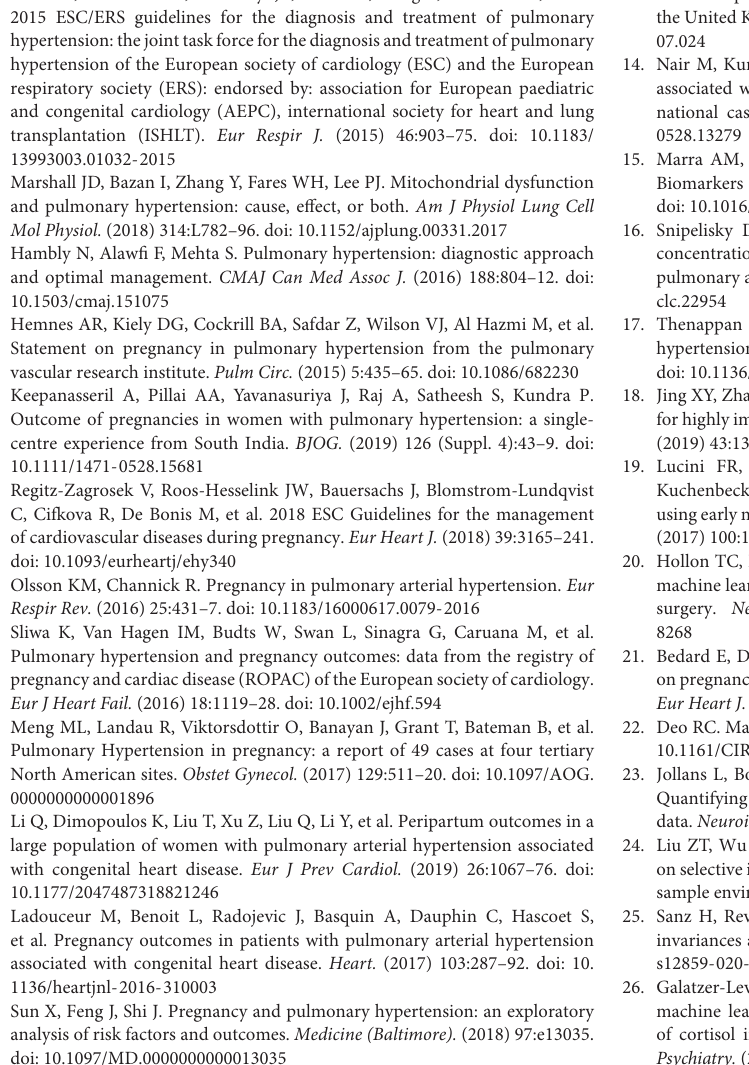
Supplementary Figure 1 | Correlation between variables. BUN, blood urea nitrogen; WHO; APTT, activated partial thromboplastin time; PT, prothrombin time;